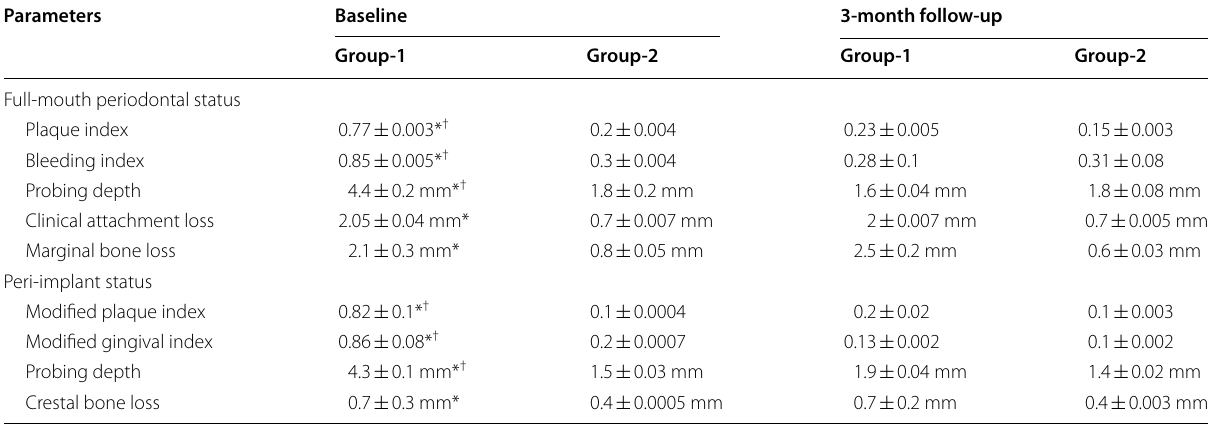
*Compared with Group-2 at baseline ( P < 0.01) using the paired t test †